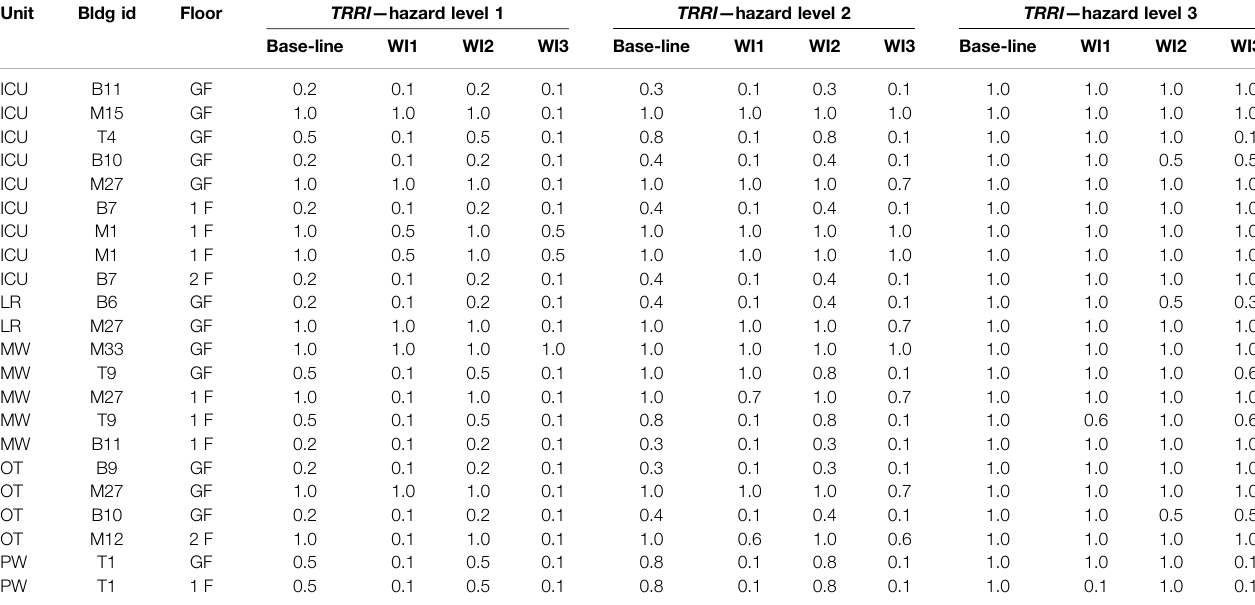
TABLE 6 | Summary of TRRI for the critical units under three hazard levels: baseline scenario and three different What-If (WI) scenarios. Unit Bldg